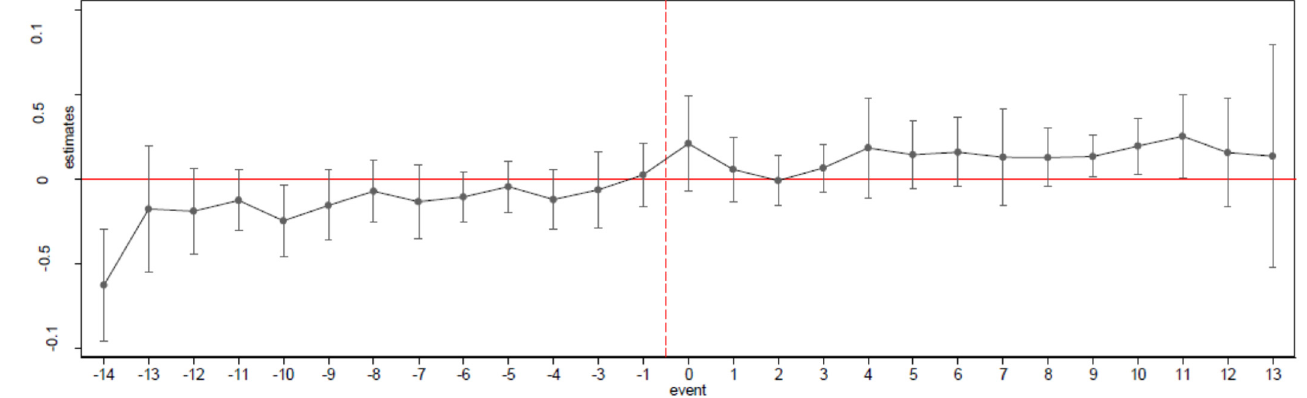
Figure 5. Parallel Trends Analysis—Event Studies on Loans Granted—Agricultural Sector.